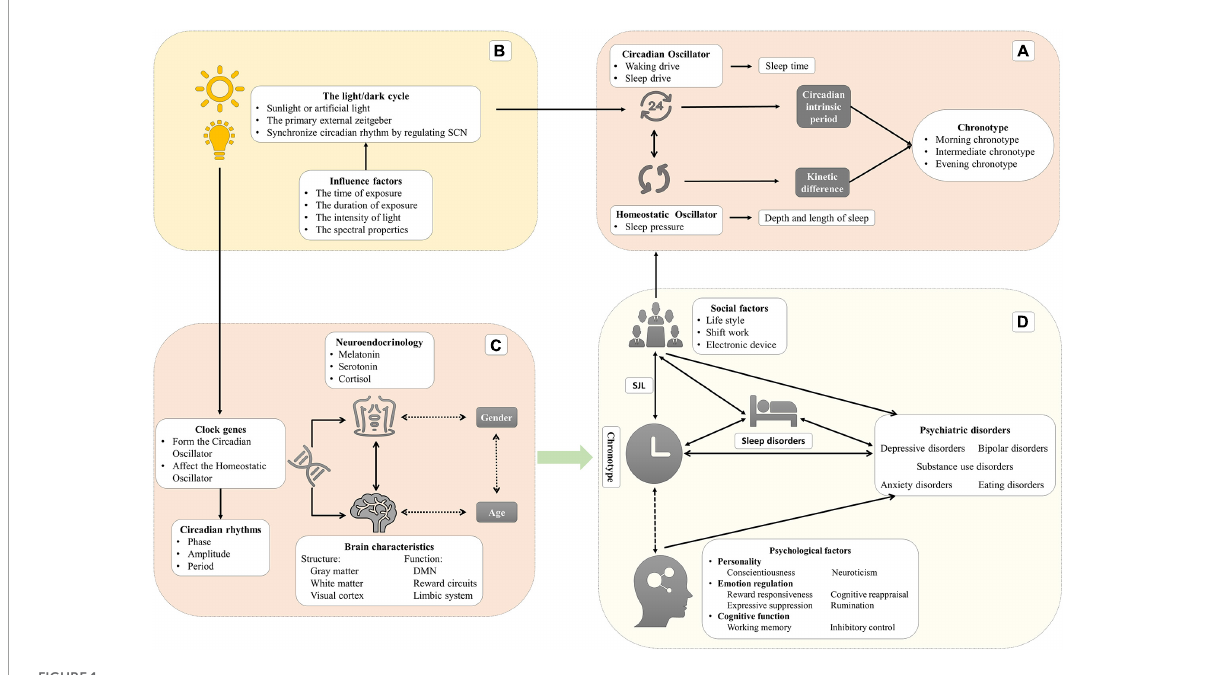
FIGURE1 Putative potential mechanisms between chronotype and psychiatric disorders. (A) The two oscillators regulate sleep parameters and lead to chronotypes. (B) The light/dark cycle and its influence factors. (C) The physiological bases contribute to differences in chronotypes. (D) The potential mechanisms and relationship between chronotype and psychiatric disorders. The direction of the arrows indicates the possible causality. The solid and dotted lines correspond to the strength of the connection. SCN, suprachiasmatic nuclei; DMN, default mode network; SJL, social jet